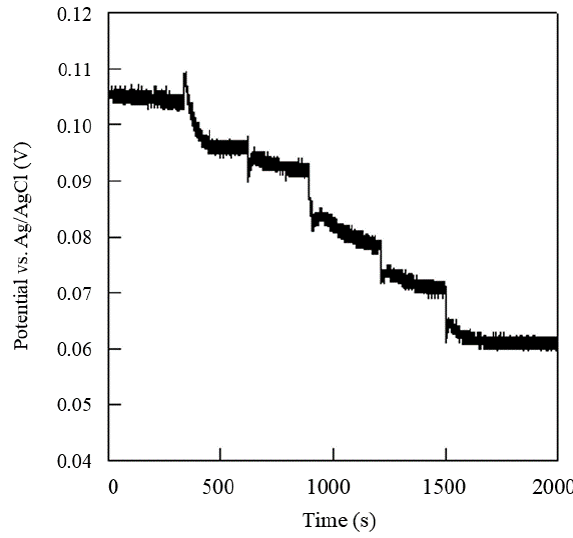
Figure 9. Potential time profile in response to the injection of urea solution.